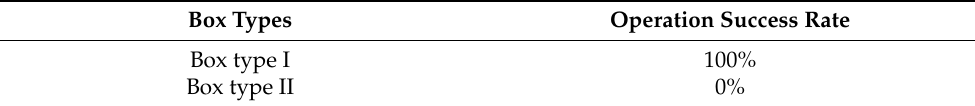
Table 3. Pick-up operation